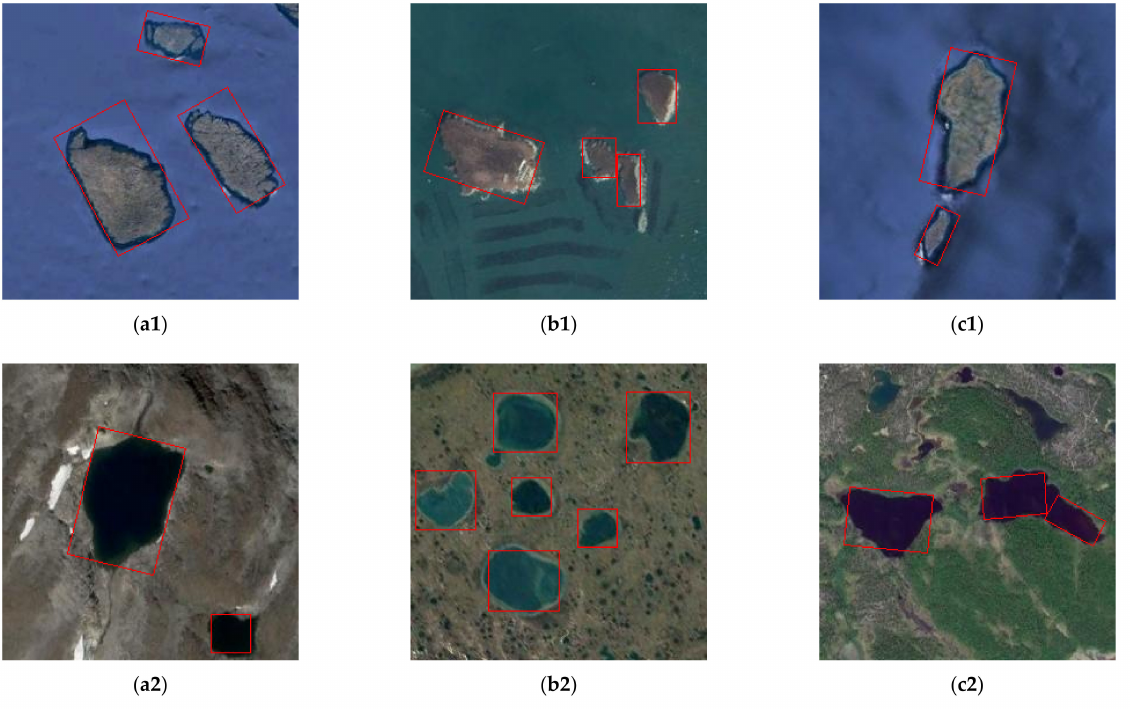
Figure 17. Experimental results based on rule marking point process algorithm: ( a1 ) Island image 1;